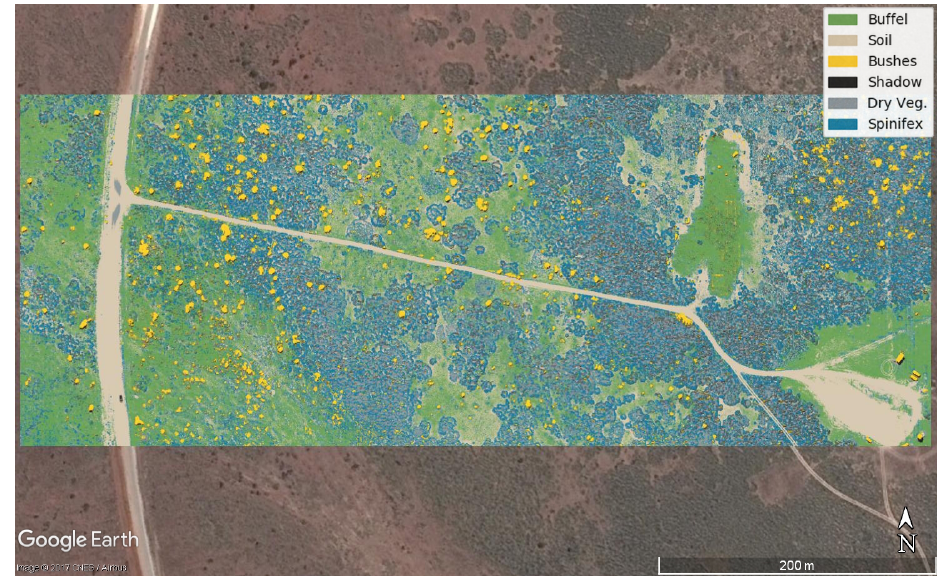
Figure 7. Prediction of invasive grasses in Cape Range National Park and its display in Google